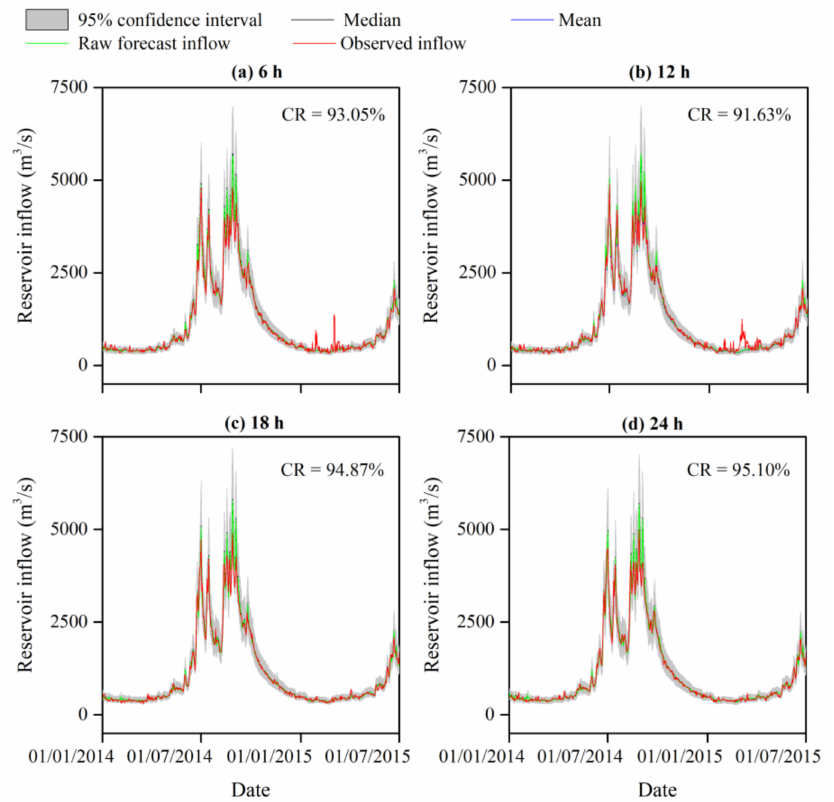
Figure 8. The 95% confidence intervals, the median and mean values of the corrected inflow ensem- bles that were derived from the developed IGMD model compared with the raw forecasted and observed inflow series for the lead times of ( a ) 6 h, ( b ) 12 h, ( c ) 18 h, and ( d ) 24 h. The median line in black and the mean line in blue were largely overlaid by the lines of the raw forecasted and observed inflow. Note that only the data during 1 January 2014 to 1 July 2015 are presented to ensure the clarity of the figure; however, the CR values were derived based on the whole study